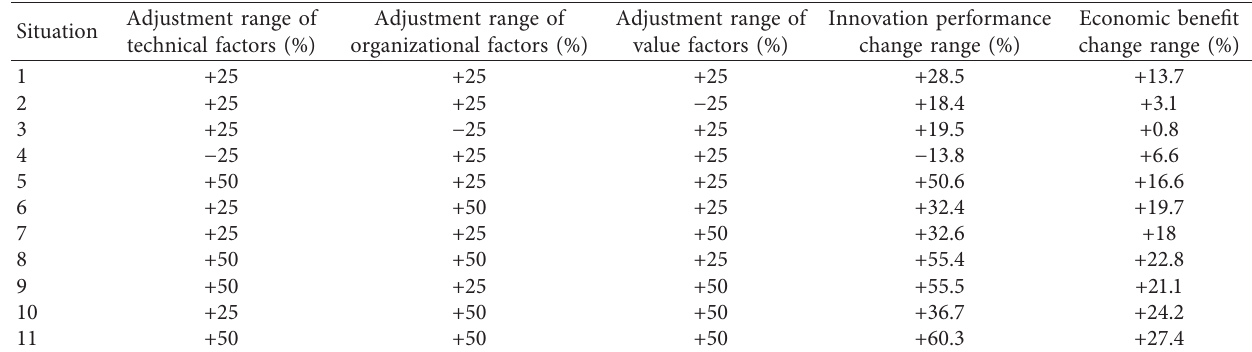
Figure 11: The influence of value factors adjustment on economic Table 6: “T-O-V” comprehensive adjustment effect simulation.